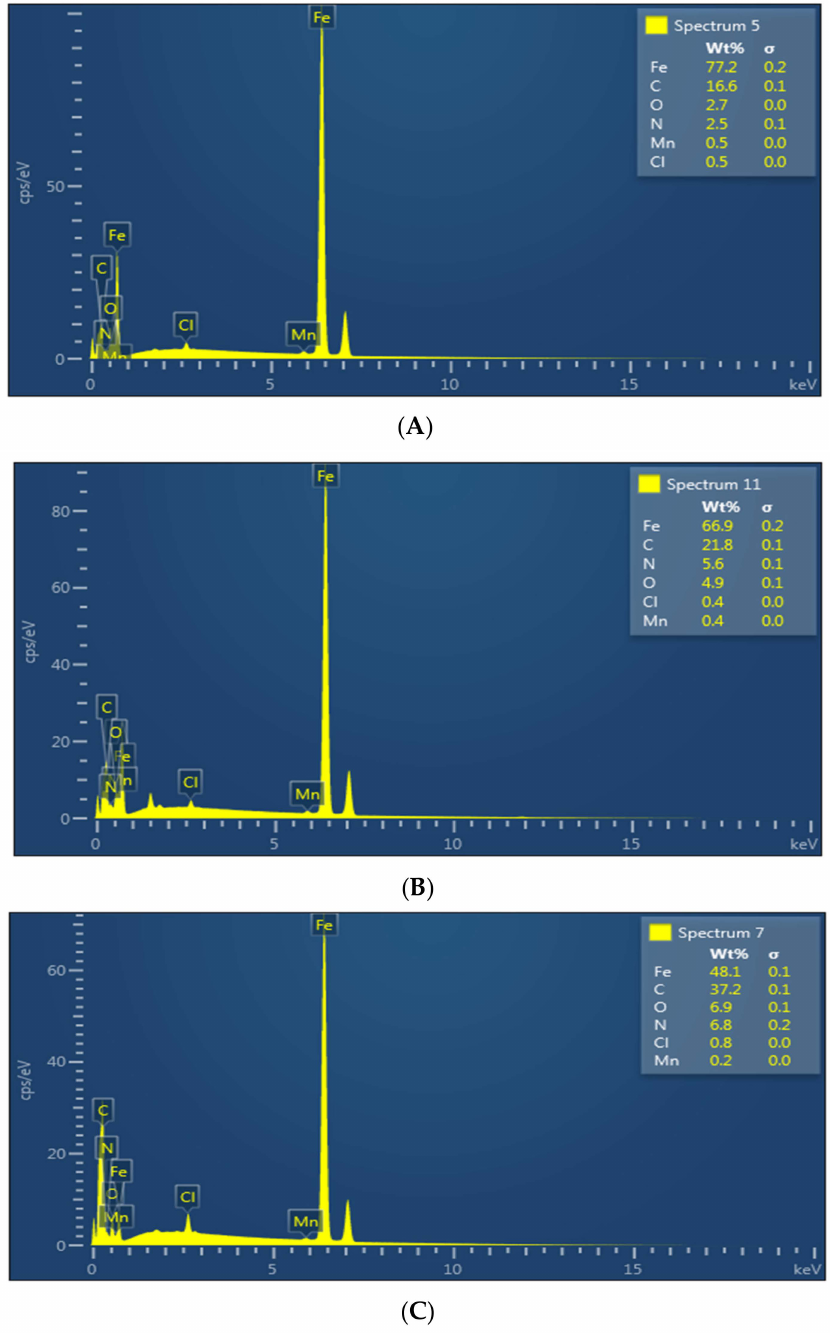
Figure 7. Energy-dispersive X-ray spectroscopy (EDS) images of the mild-steel in 1.0 M HCl con- taining 5 × 10 − 3 M of BMPyrIM ( A ), BMImIM ( B ) and BBMImIM ( C ) ionic liquids at 25 ◦ C after immersion for 24